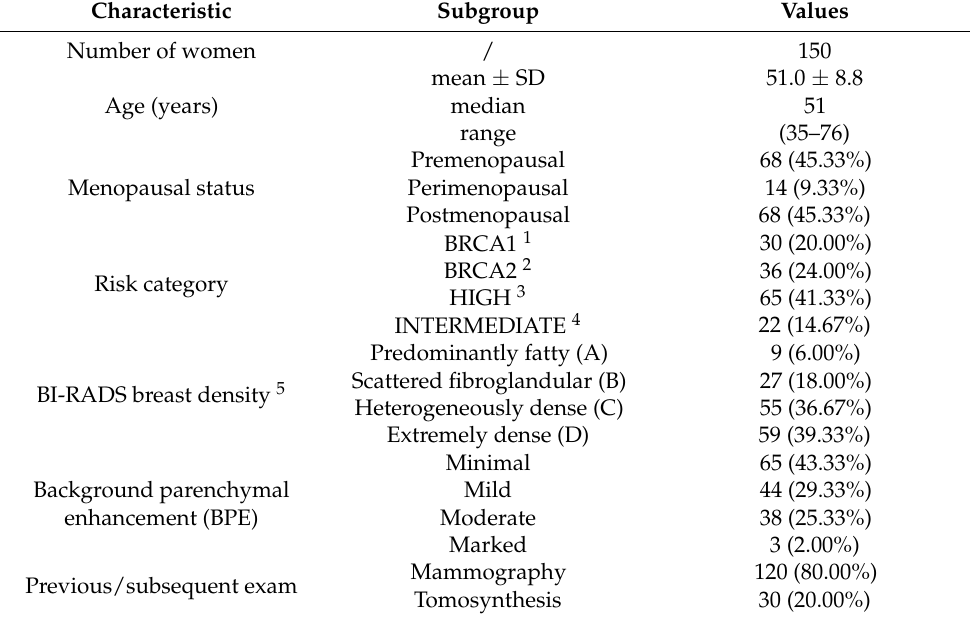
Table 1. Characteristics of study